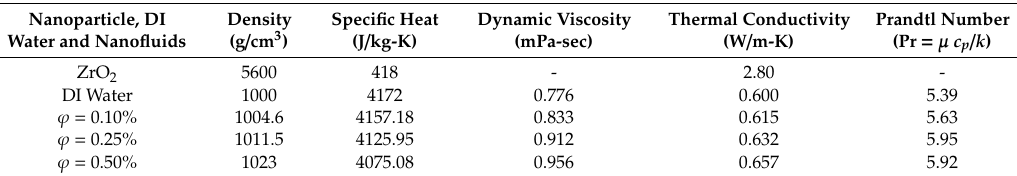
Table 1. Thermo-physical properties of ZrO 2 nanoparticles, deionized water, and ZrO 2 /DI water nanofluids. water nanofluids.